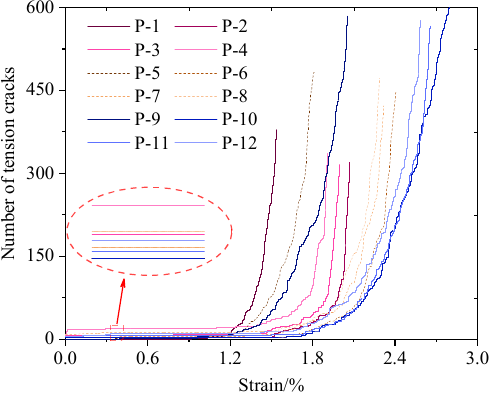
Figure 15. Development of cracks in coal body failure process in different models.